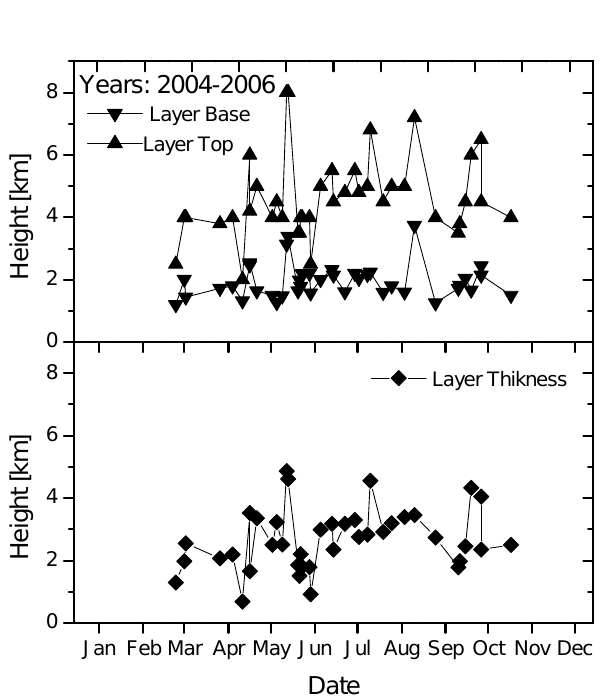
Fig. 6. Annual cycle of the backscatter weighted altitude of the desert dust layer ( z c ) (upper part) and of the integrated backscatter coefficient (IBC) (lower part) for the three-years period (January 2004–December 2006). The solid line in the upper figure is the 5-days sliding